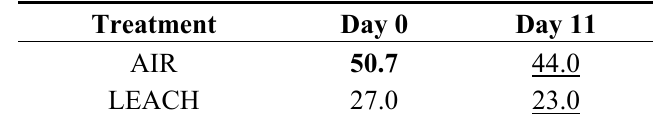
Table 2. Richness (S) index based on PCR-DGGE data for intermittently aerated (AIR) and unaerated (LEACH) soil from leachfield mesocosms before (Day 0) and after (Day 11) dosing with